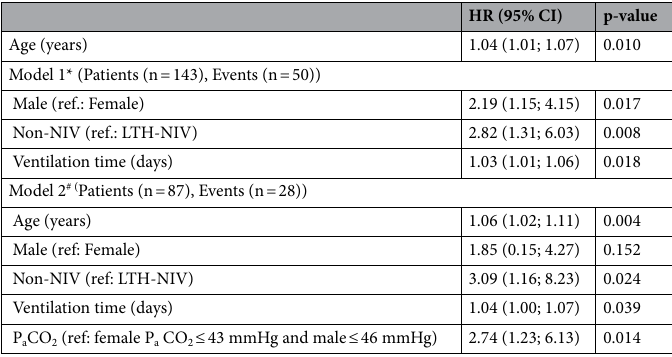
Table 4. Two different models for the calculation of predictive variables for survival in multivariate Cox analysis. HR hazard ratio, CI confidence interval. *Model 1 included age, gender, ventilation therapy, and ventilation time. # Model 2 included age, gender, ventilation therapy, and ventilation time, P a CO 2 .